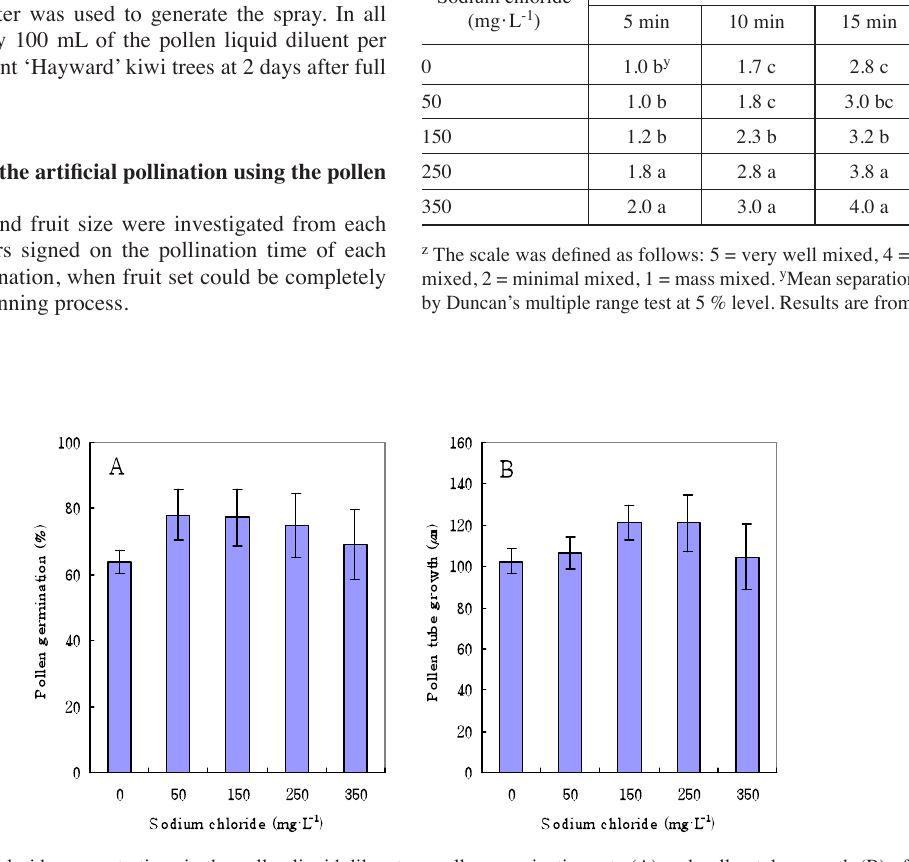
Fig. 1: Effects of sodium chloride concentrations in the pollen liquid diluent on pollen germination rate (A) and pollen tube growth (B) of ‘Matua’ kiwi in vitro. Vertical bars represent ± SD. Results are from five replicates. Replicates above consist of approximately 50 pollen grains